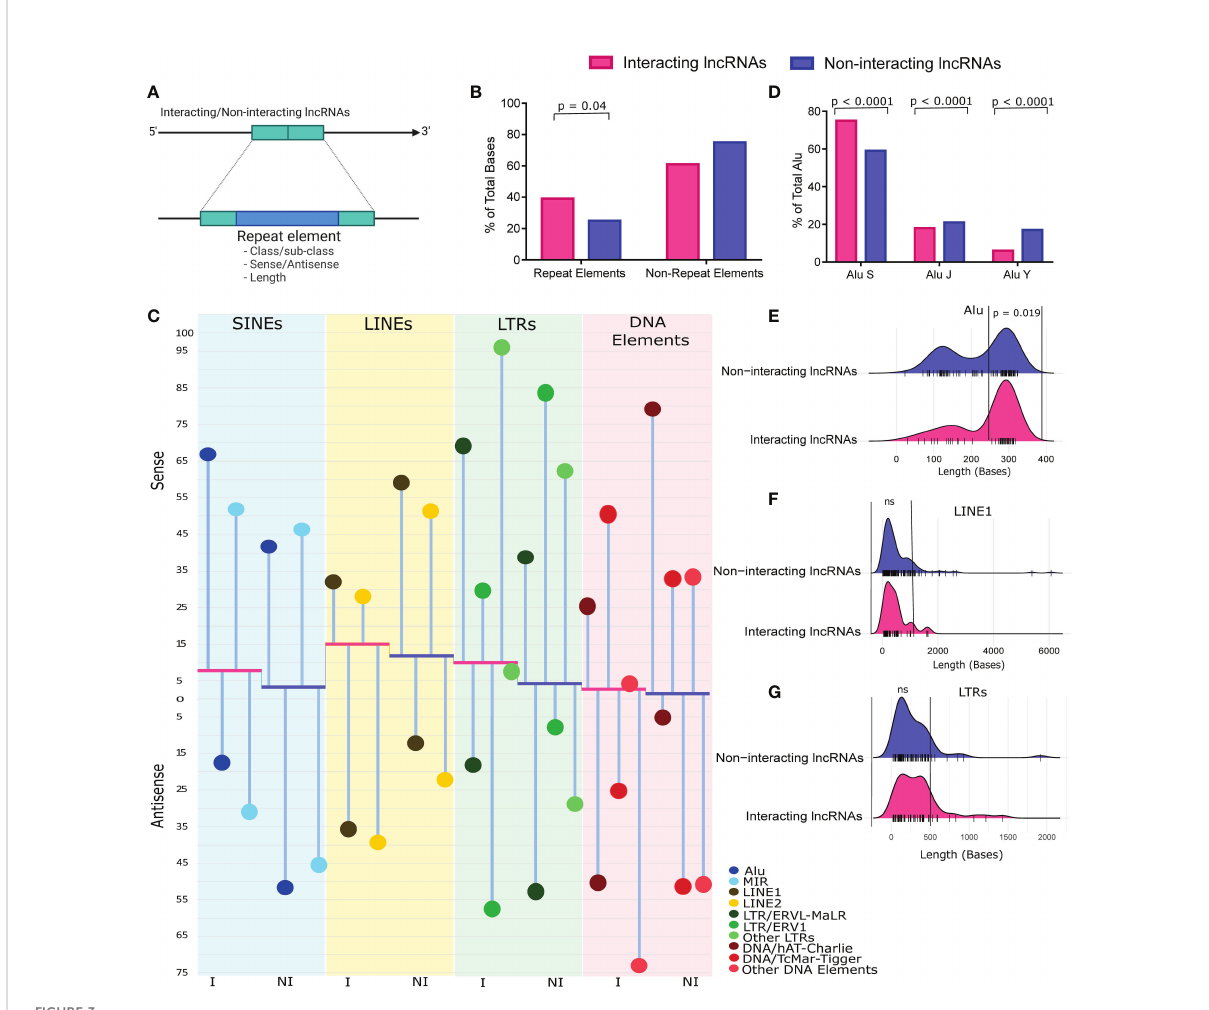
FIGURE 3 Repeat element abundance, class/subclass, strand-speci fi c differential presence and size range of the Repeats. (A) Working model of the repeat element abundance analysis. (B) Repeat element abundance between the vaccination breakthroughs and the unvaccinated. Total bases covered by repeat elements were normalized against total lncRNA length. (C) Repeat element class/sub-class, and their strand speci fi c distribution between the two groups. Abundance of major repeat classes are represented by bars, while height of bars from baseline indicates the abundance of repeats normalized to the lncRNA length. The red base of the plot corresponds to interacting lncRNAs (I) , while the blue base corresponds to the non-interacting lncRNAs (NI). Abundance of repeat sub-classes are represented as %age of the repeat class (lollipop plot). (D) Abundance of Alu subfamily between the two groups. Data is represented as %age of total Alu, normalized against total bases covered by the Alus. (E – G) Size distribution of (E) Alu, (F) LINE1, and (G) LTRs, normalized against the number of such repeats. The bars at the base of the ridge indicate the individual repeat element of that speci fi c size